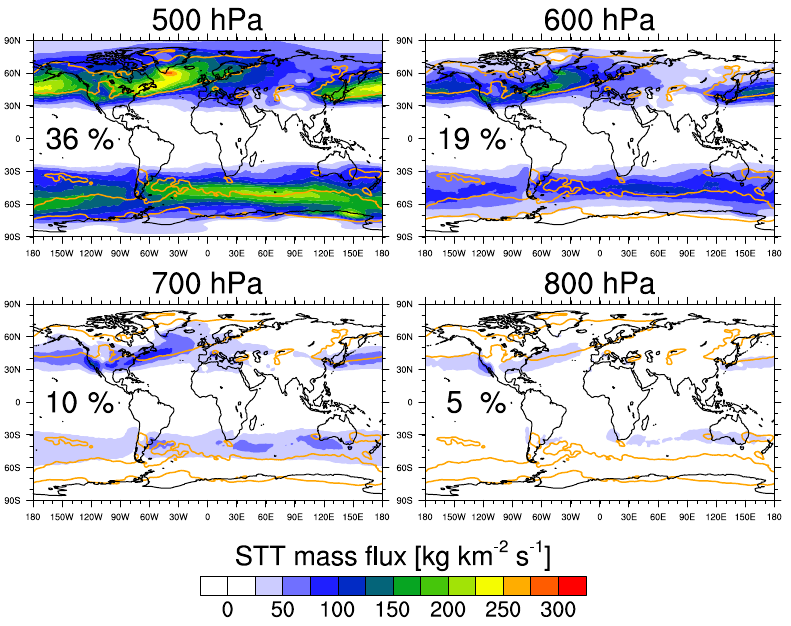
Fig. 4. STT mass flux through the 500, 600, 700, and 800hPa pressure surfaces of all STT events averaged over the period from 1979 to 2011 (annual mean). The orange contours indicate areas where the STT mass flux across the tropopause is greater than 300kgkm − 2 s − 1 . The percentage values indicated in the panels are calculated with respect to the globally integrated STT mass flux across the